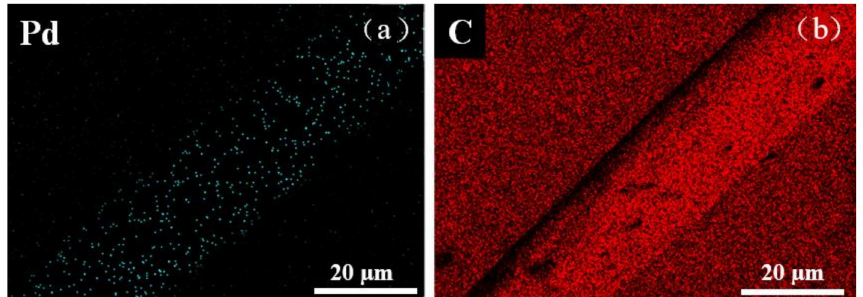
Figure 4. EDS of Pd-loaded carbon felt electrode (0.5 mg/cm 2 ), ( a ) Pd element scatter, ( b ) C element scatter.